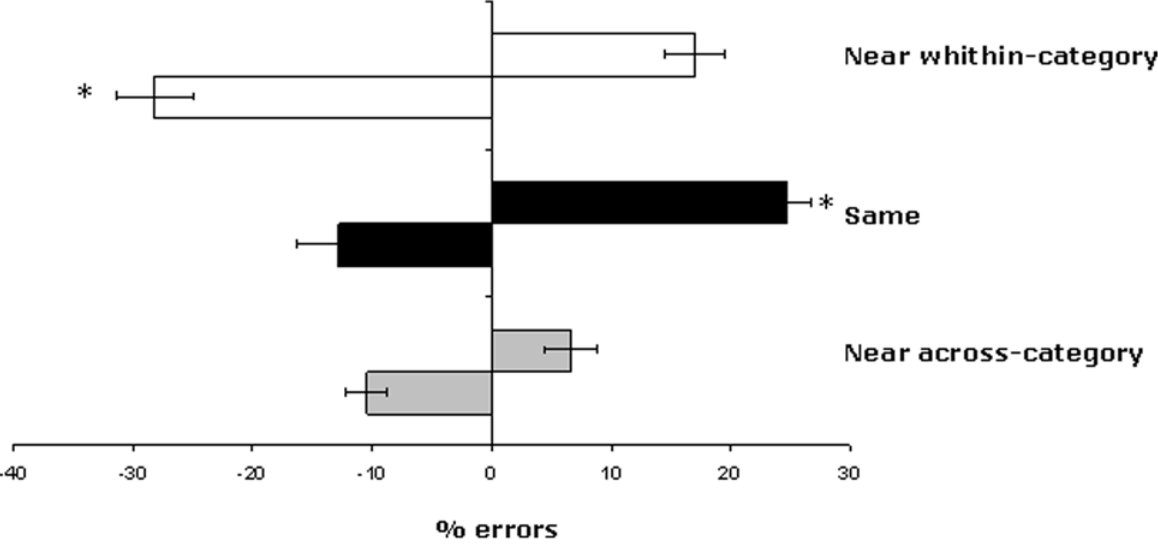
Figure 4. Experiment 4: Spatial judgment task. Mean leftward and rightward errors ( 6 1 SE) as a function of the different experimental conditions. Negative values indicate leftward shifts and positive values rightward shifts in the